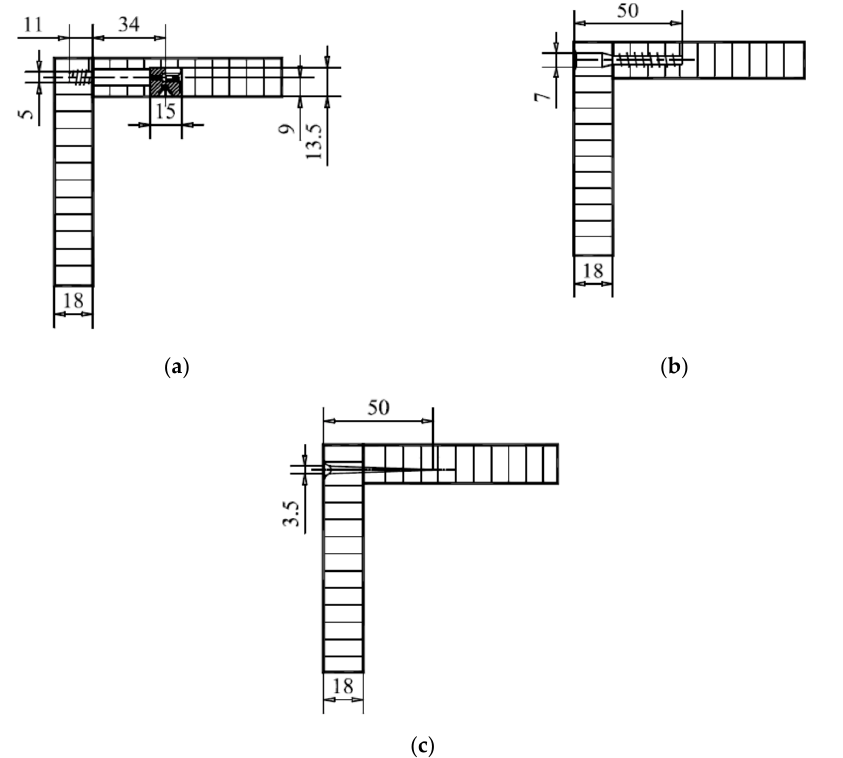
Figure 3. Types of joints: ( a ) Minifix, ( b ) one-piece connector Confirmat ø7 × 50 mm and ( c ) screw for wood ø3.5 × 50 mm.